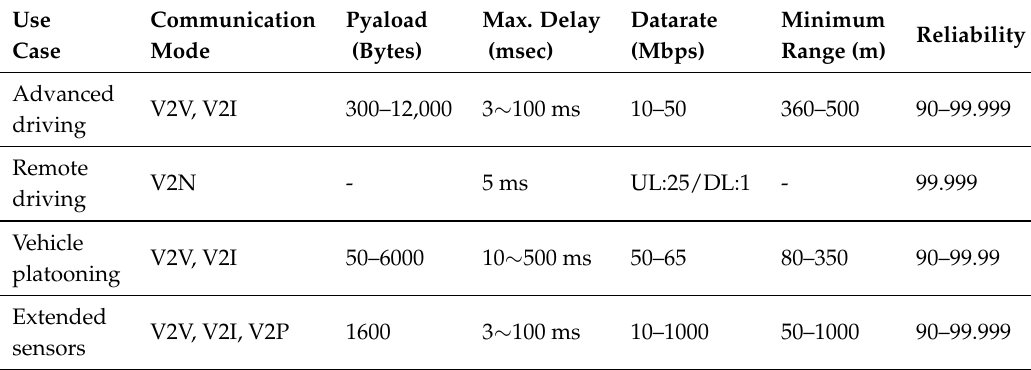
Table 2. Advanced use cases and Quality of Service (QoS) requirements of Vehicle to Everything (V2X) applications